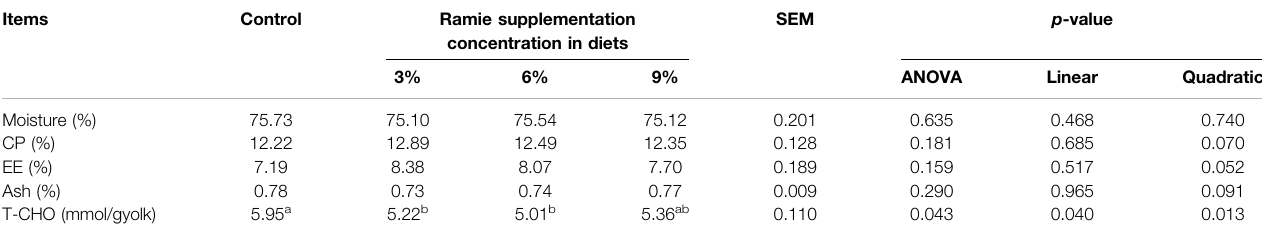
TABLE 5 | Effects of dietary ramie supplementation on Nutritional Composition of Whole Egg and Total Cholesterol Content in Egg Yolk.